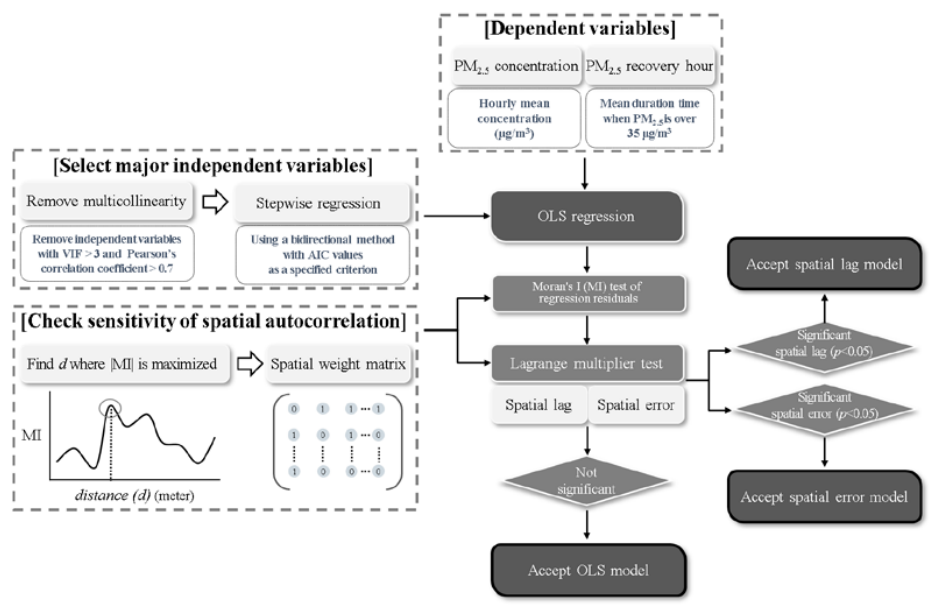
Figure 2. Process used to select an appropriate regression model for PM 2.5 concentration and recovery hour.